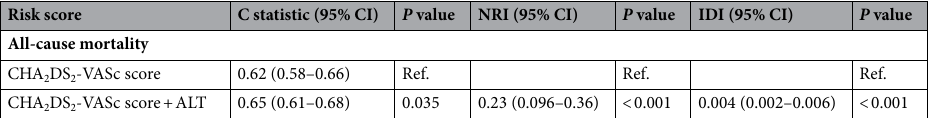
Table 3. Evaluation of ability of baseline alanine aminotransferase level vs CHA 2 DS 2 -VASc score to predict all-cause mortality. ALT alanine aminotransferase, CHADS 2 congestive heart failure, hypertension, age ≥ 75 years, diabetes, and stroke, CHA 2 DS 2 -VASc congestive heart failure, hypertension, age ≥ 75 years, diabetes, stroke, vascular disease, age 65–74 years, and male, CI confidence interval, NRI net reclassification improvement, IDI integrated discrimination